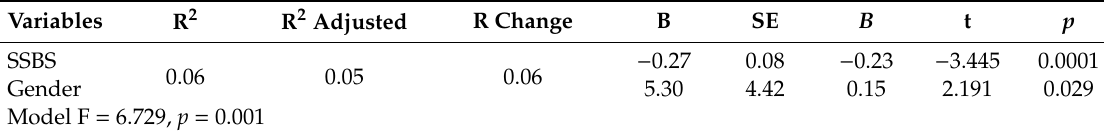
Table 2. Multiple linear regression model of Problematic Internet Use.